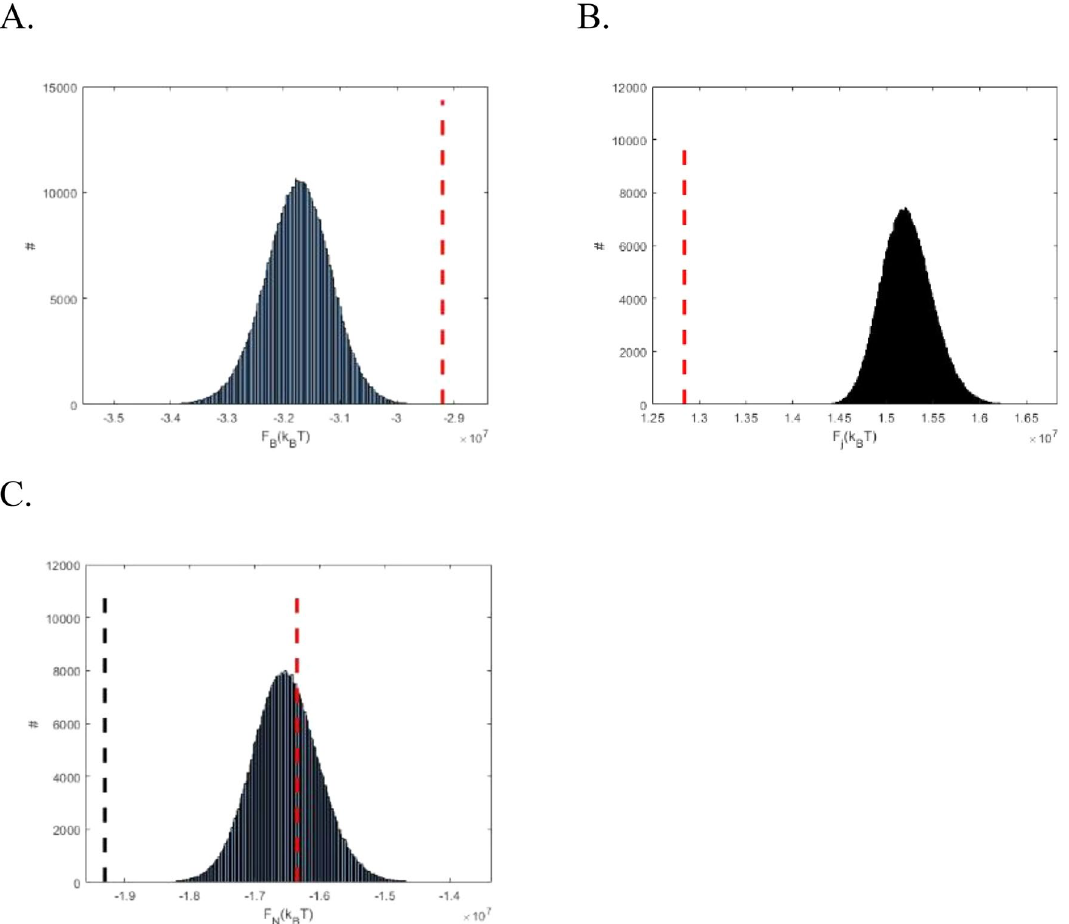
Figure 4. Histograms for distributions of the bundle energy ( A ) junction energy ( B ) and total network energy ( C ) calculated for the ensemble of the irregular network configurations generated by random Voronoi tessellations for the following values of parameters: N j The vertical dashed red lines show the bundle, junction and total energies for the corresponding hexagonal network. The vertical dashed black line in panel ( C ) indicates the realization with the lowest total energy found in the